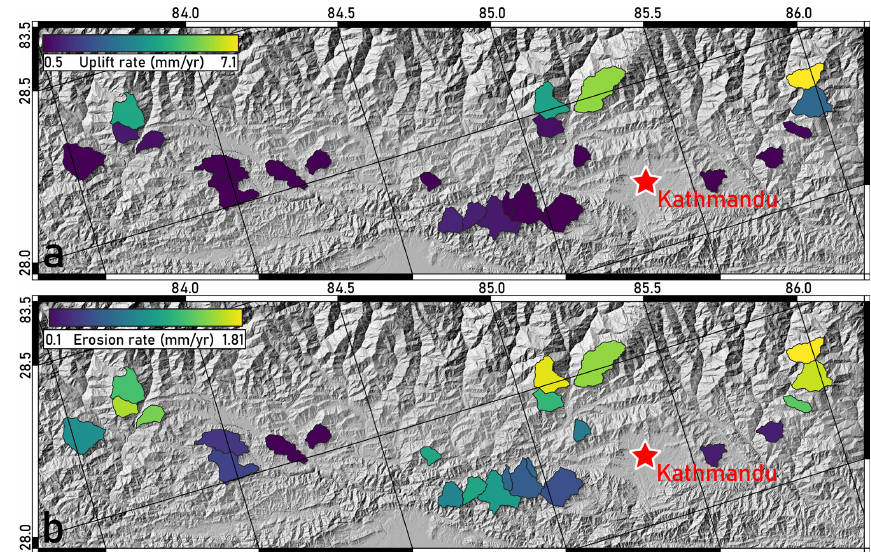
Figure 6. (a) Estimated uplift rate for basins with no or minimal drainage area above the LGM ELA (Lavé and Avouac, 2001). (b) Beryllium- 10-derived basin-averaged denudation rates for the same basins (Godard et al., 2014).